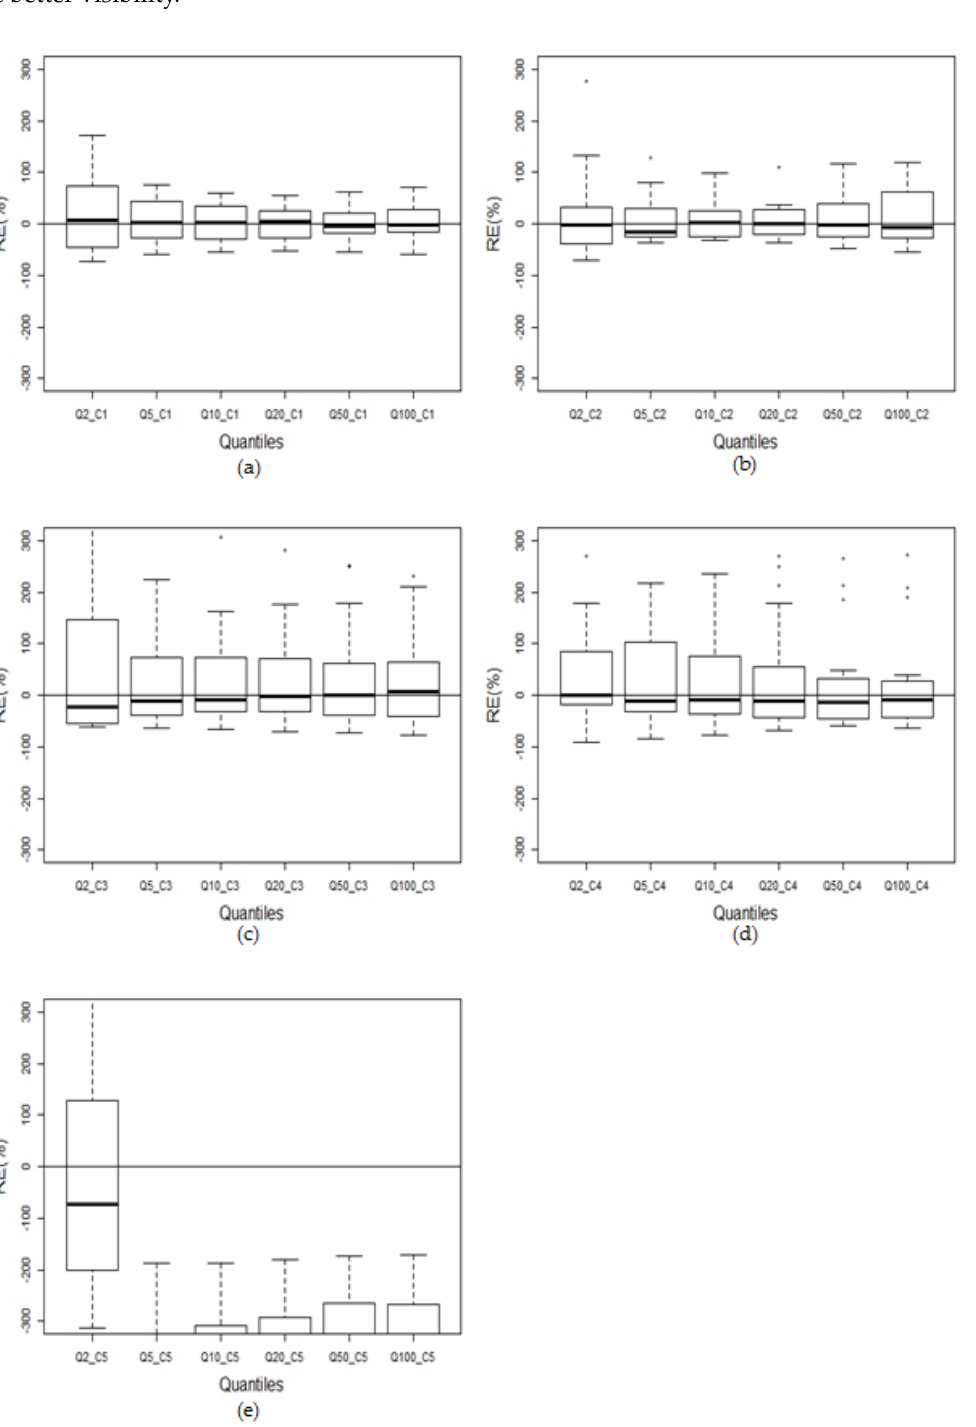
Figure 11. Boxplots of RE for all clusters and AEPs: ( a ) cluster 1 (C1); ( b ) cluster 2 (C2); ( c ) cluster 3 (C3); ( d ) cluster 4 (C4); and ( e ) cluster 5 (C5).